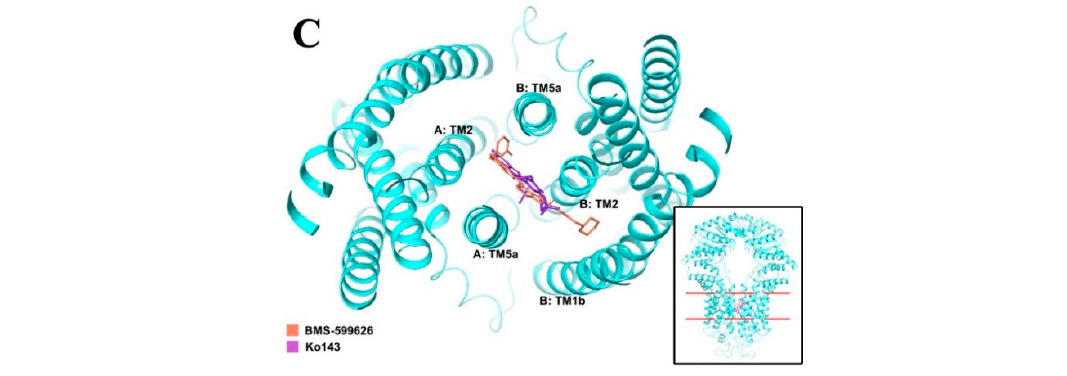
Figure 8. Induced-fit docking (IFD) predicted the best-scored binding pose of BMS-599626 in human ABCG2 model. ( A ) Overview of the binding location of BMS-599626 (with crimson surface) in human ABCG2 (cyan ribbon diagram) and the detailed bonding interactions are shown. The location of BMS-599626 within the drug-binding cavity shown as a ball and stick model with the following colors: carbon, orange; hydrogen, white; oxygen, red; nitrogen, blue; and fluorine, green. Important amino acids are depicted as sticks in the same scheme except with carbon as grey. Dotted yellow lines and dotted blue lines are indicative of hydrogen-bonding interactions and π - π stacking interactions, respectively. Values of the relevant distances are provided in Å. ( B ) The two-dimensional ligand-receptor interaction diagram of BMS-599626 and human ABCG2. The amino acids within 4 Å are shown as colored bubbles, polar residues are shown in blue color, and hydrophobic residues are indicated in green color. Hydrogen bonds and π - π stacking aromatic interactions are shown by the purple arrow and green lines, respectively. ( C ) The docked conformations of BMS-599626 (orange) and Ko143 molecules (purple) into human ABCG2 (6ETI) as stick model is magnified for better view. Important interacting TMs of ABCG2 are